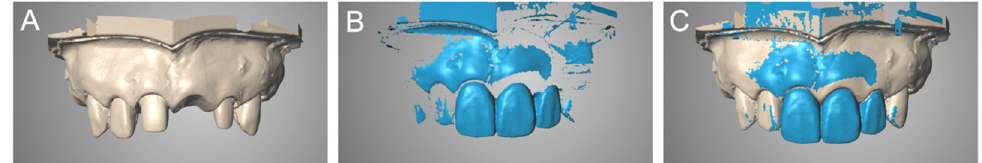
Figure 2. Scan data of cast created by the conventional method. ( A ) Working casts. ( B ) Form reference cast of the provisional restoration. ( C ) The two STL data were superposed.